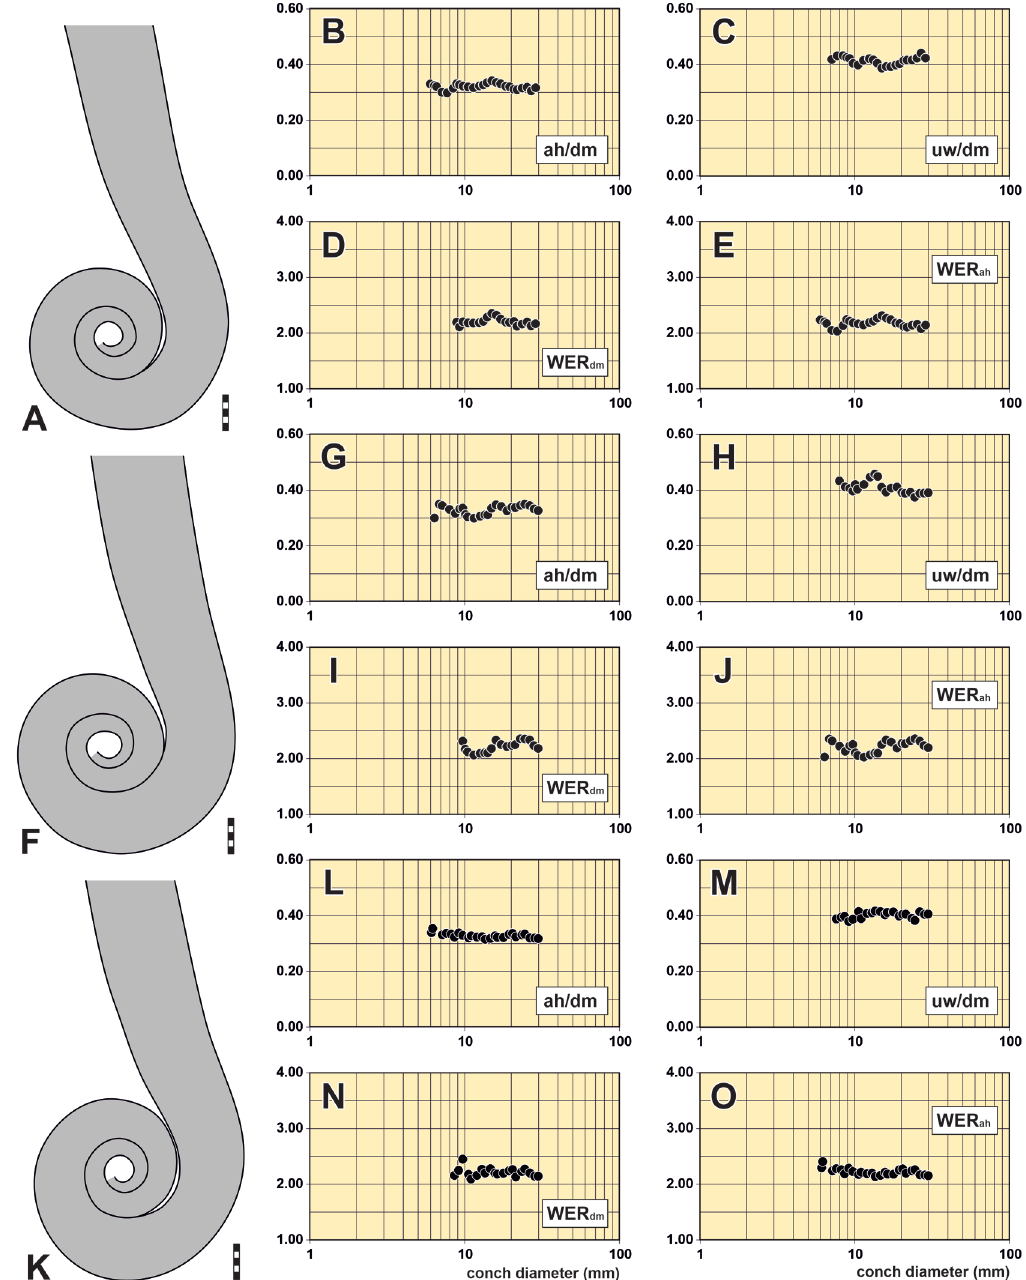
Fig. 34. Lituites lituus de Montfort, 1808. A . Outline of coiled conch part of neotype MB.C.30527. B–E . Conch proportions and coiling rates of neotype MB.C.30527. F . Outline of coiled conch part of specimen MB.C.2497. G–J . Conch proportions and coiling rates of specimen MB.C.2497. K . Outline of coiled conch part of specimen MB.C. 11990. L–O . Conch proportions and coiling rates of specimen MB.C. 11990. Scale bar units = 1